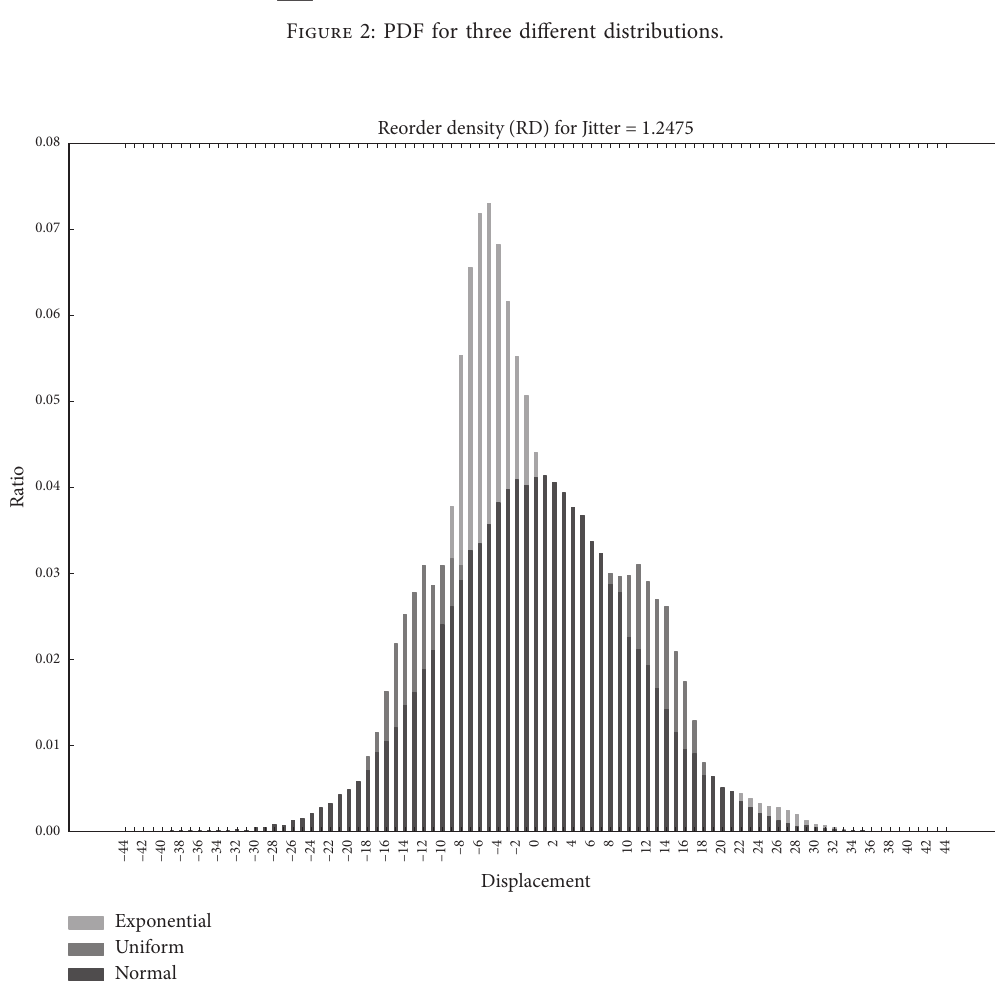
Figure 3: RD measured for each probability